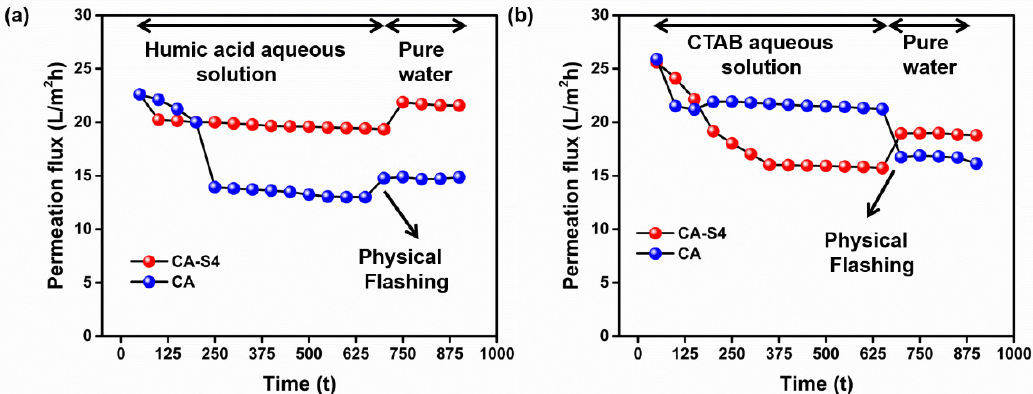
Figure 6. Time-dependent permeation flux (L/m 2 h) through an NF-TFC membrane using model foulants ( a ) humic acid and ( b ) cetyl trimethylammonium bromide (CTAB).